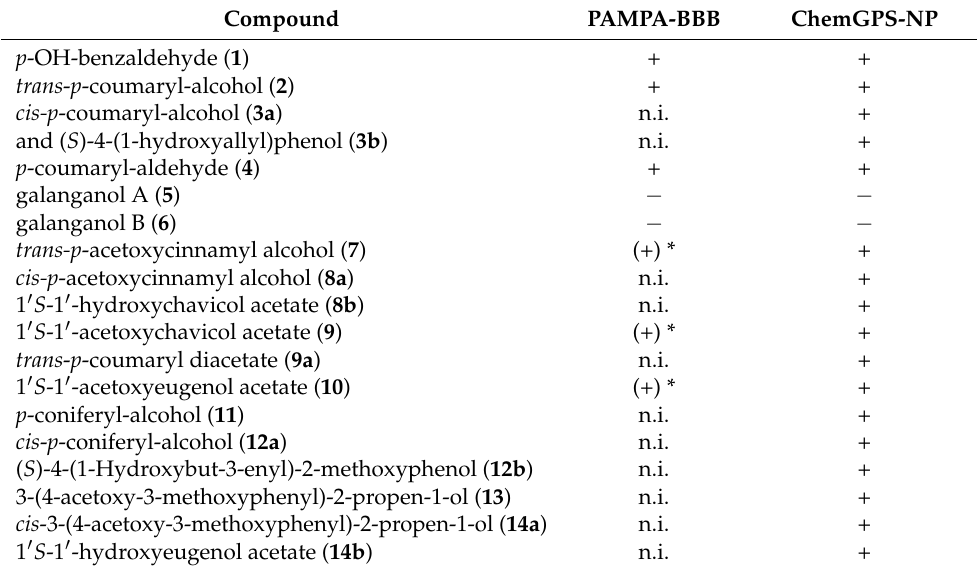
Table 1. Blood–brain barrier permeability of A. galanga compounds and degradation products determined by the PAMPA-BBB and ChemGPS-NP.